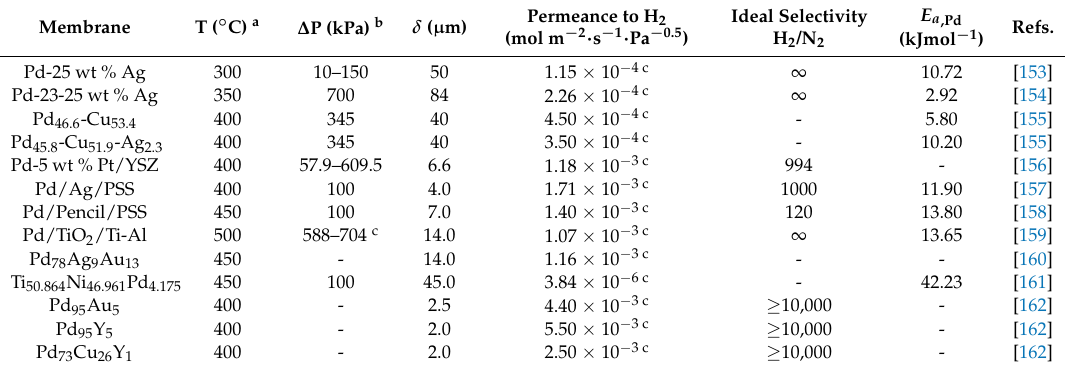
Table 2. Specifications of membranes already disclosed in published studies (adapted from Silva et al. [73]).